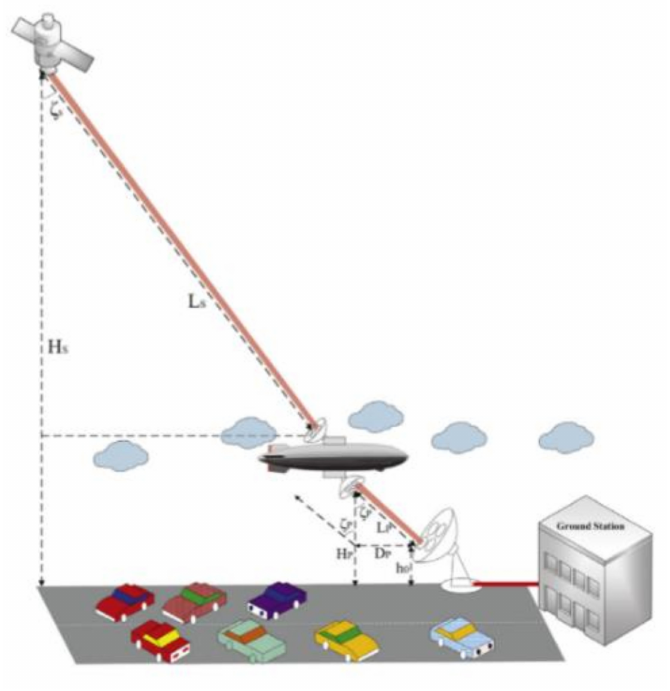
Figure 4. Laser communication scenarios from HAPs